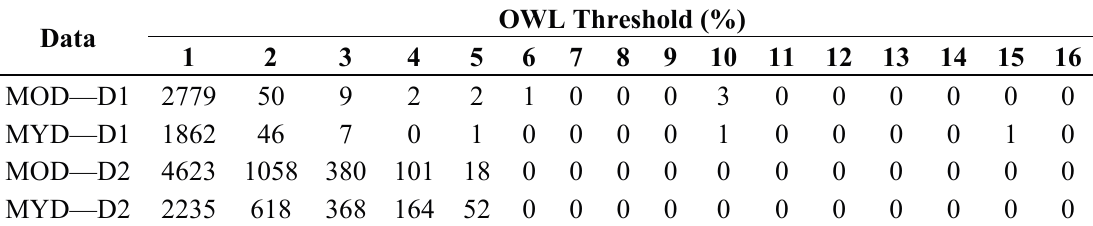
Table 1. Number of pixels erroneously identified as having water for the different MODIS OWL threshold values for sites D1 and D2. All MOD and MYD data for the 2003, 2004, 2009 and 2010 wet seasons are used (with the exception of the Site D2 dry periods with a small relative azimuth angle). Those images erroneously identified as water with a 6% OWL threshold or greater contain cloud shadow (at 6% and 10%) or a fire scar (at